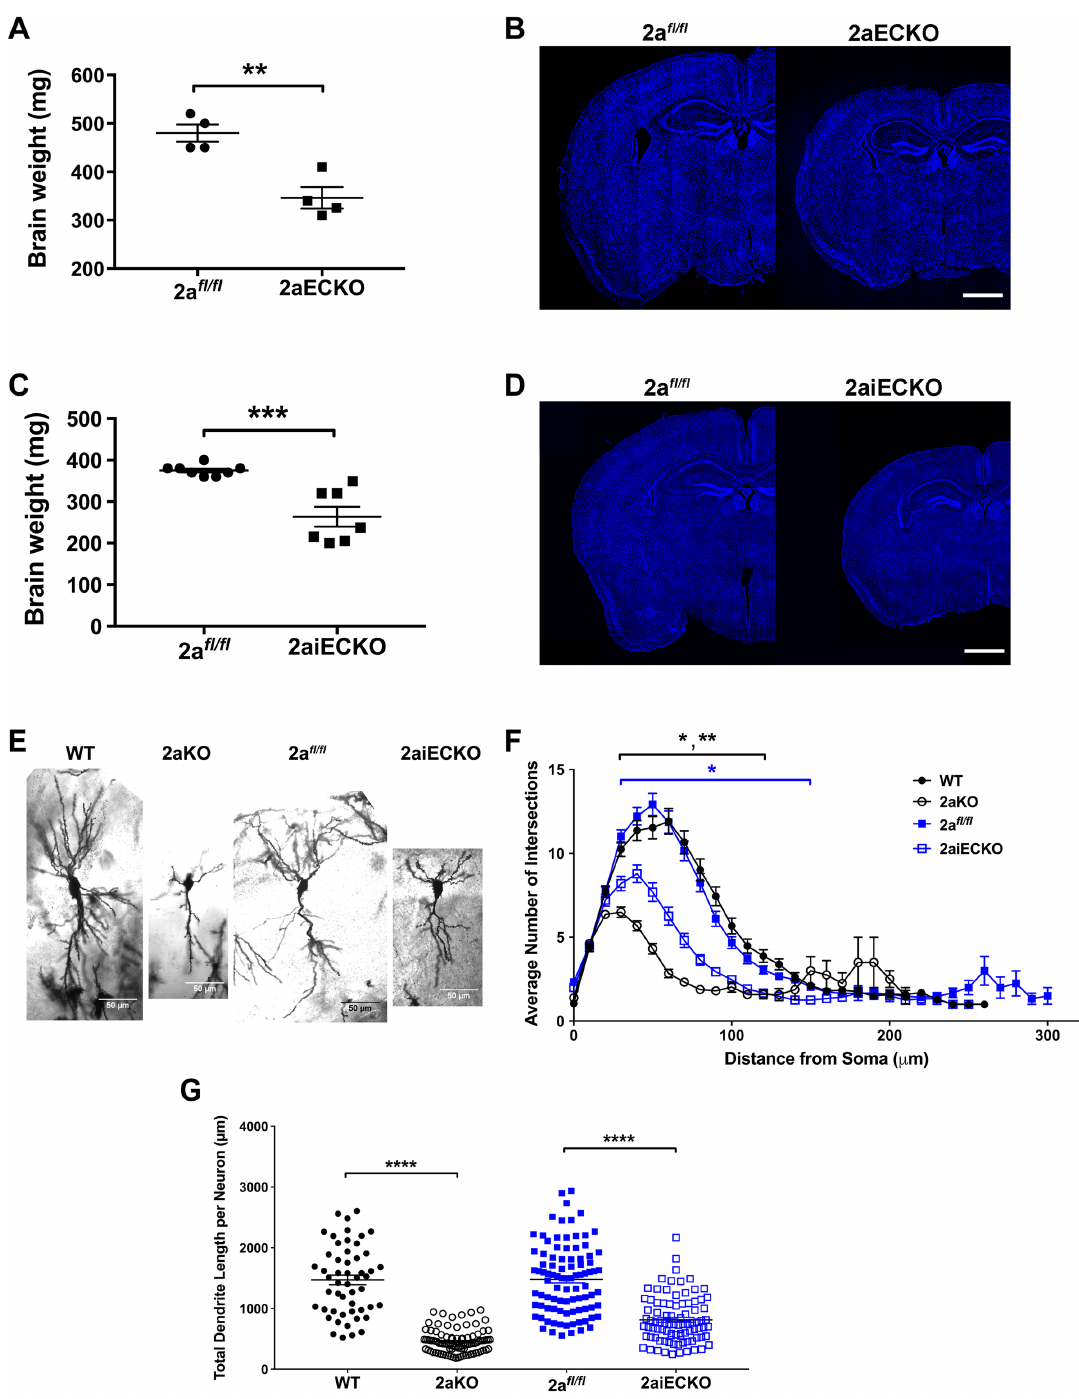
Fig 1. Mfsd2a is required at the BBB for postnatal brain growth. (A) Reduced brain weights of 8-week-old 2aECKO relative to 2a fl/fl mice. Data are represented as mean ± SE. 2a fl/fl , n = 4; 2aECKO, n = 4. (cid:3)(cid:3) p < 0.01. (B) Coronal sections indicate reduced brain size of 8-week-old 2aECKO relative to 2a fl/fl mice. Sections were stained with Hoechst. Scale bar, 1 mm. (C) Reduced brain weights of 4-week- old 2aiECKO relative to 2a fl/fl mice. Data are represented as mean ± SE. 2a fl/fl , n = 8; 2aiECKO, n = 7. (cid:3)(cid:3)(cid:3) p < 0.001. (D) Coronal sections indicate reduced brain size of 4-week-old 2aiECKO relative to 2a fl/fl mice. Sections were stained with Hoechst. Scale bar, 1 mm. (E) Representative images of Golgi-stained hippocampal neurons in brain sections of 3-week-old WT and 2aKO, and 4-week-old 2a fl/fl and 2aiECKO mice. n = 2 of each genotype. Scale bar = 50 μm. (F) Sholl analysis of Golgi-stained hippocampal neurons in sections of brains from 3-week-old WT and 2aKO, and 4-week-old 2a fl/fl and 2aiECKO mice. An average of 44 neurons were analyzed for each brain.